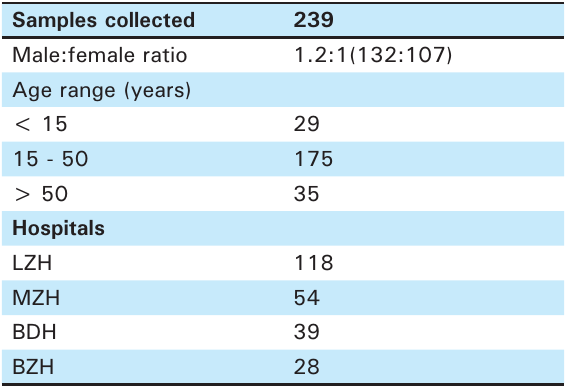
Table 1. Distribution of the subjects by sex, age and